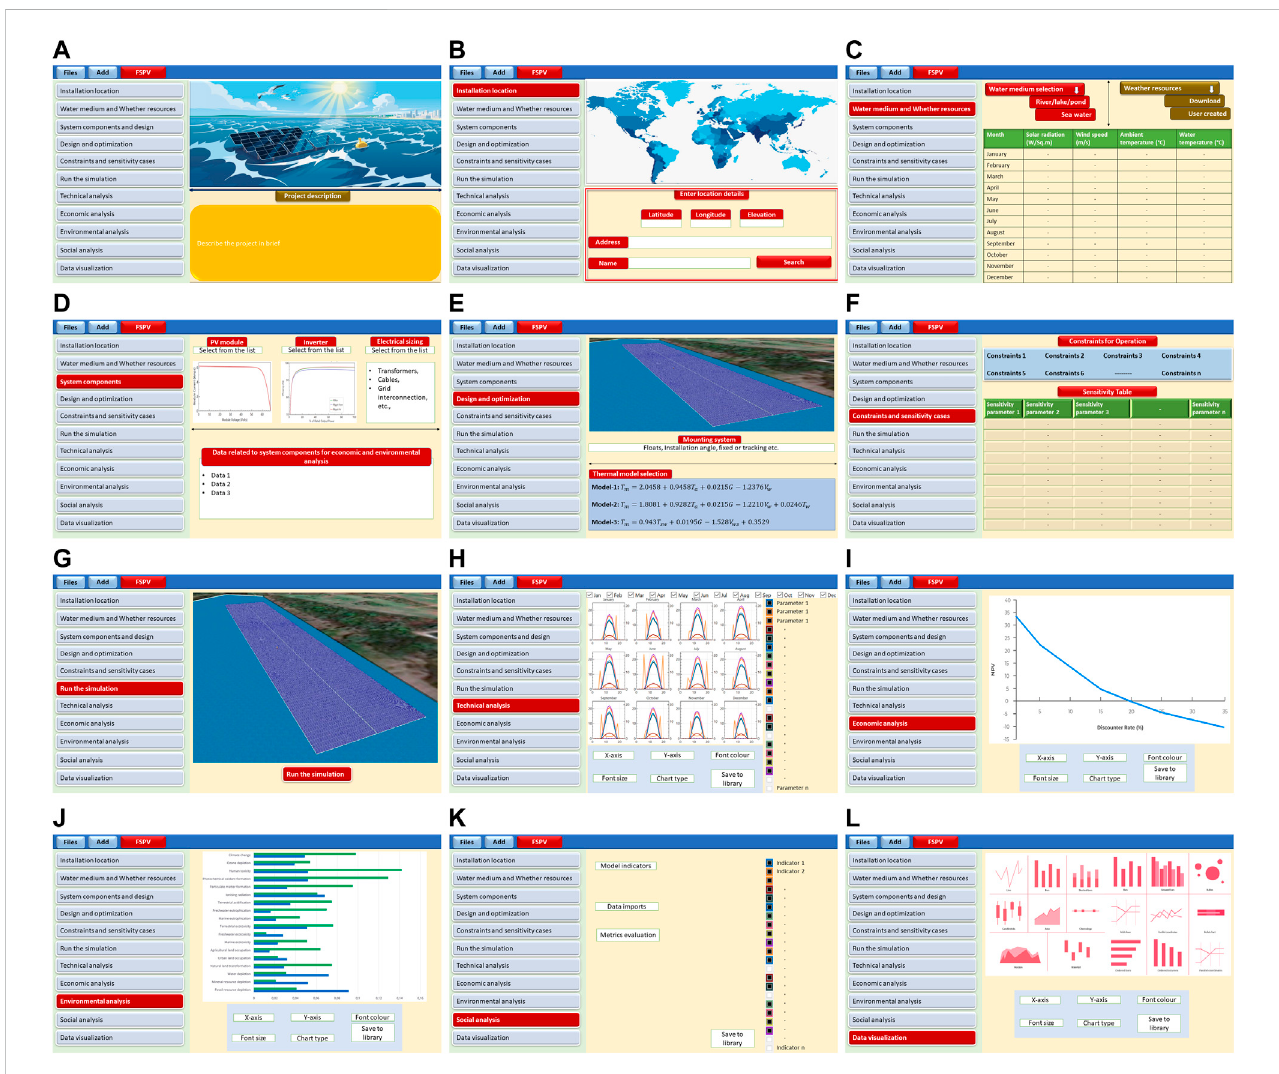
FIGURE 8 Theconceptual modeloftheFSPVsimulation modellingtool as pertechno-economic-environmentalandsocial framework. (A) Openingpagefor FSPV modelling and analysis; (B) Installation location window; (C) Water medium and Whether resources window; (D) System components; (E) Design and optimization window; (F) Constraints and sensitivity cases; (G) Run the simulation window; (H) Technical analysis window; (I) Economic analysis window (J) Environmental analysis window (K) Social analysis window (L) Data visualiazaiton window. Note: The performance modelling concept and design layout of the tool was adopted from author ’ s own source in ref (Kumar et al., 2022) with permission from different